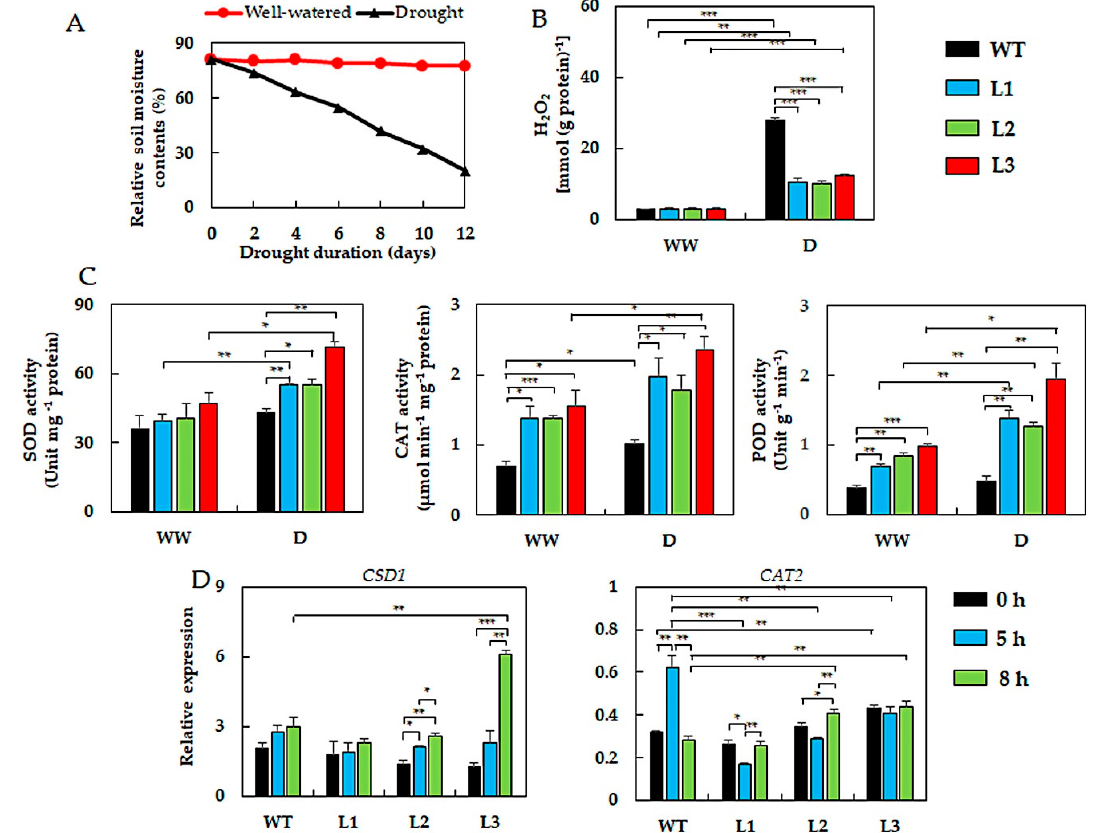
Figure 3. Cellular hydrogen peroxide (H 2 O 2 ) content, and antioxidant defense-related enzyme activities and gene expression in GmNAC019 -transgenic Arabidopsis (L1, L2, L3) and wild-type (WT) plants under normal and water-stressed conditions. ( A ) Monitored relative soil moisture content during a 12-day period of soil-drying ( n = 6). ( B ) Cellular H 2 O 2 content ( n = 3) with irrigation (WW) or without irrigation (D) for 12 days. ( C ) Activities of superoxide dismutase (SOD), catalase (CAT) and peroxidase (POD) enzymes with irrigation or without irrigation for 12 days ( n = 3). ( D ) Expression pattern of CSD1 ( copper / zinc superoxide dismutase 1 ) and CAT2 ( catalase 2 ) genes in plants subjected to 0, 5 and 8 h of dehydration ( n = 3). The drought and dehydration treatments were applied to four-week-old and three-week-old plants, respectively. Error bars represent SEs. Asterisks indicate significant di ff erences (* p -value < 0.05; ** p -value < 0.01; *** p -value < 0.001) between each transgenic line and WT plants grown under the same conditions, and within the same genotype exposed to two treatment conditions, according to a Student’s t -test.